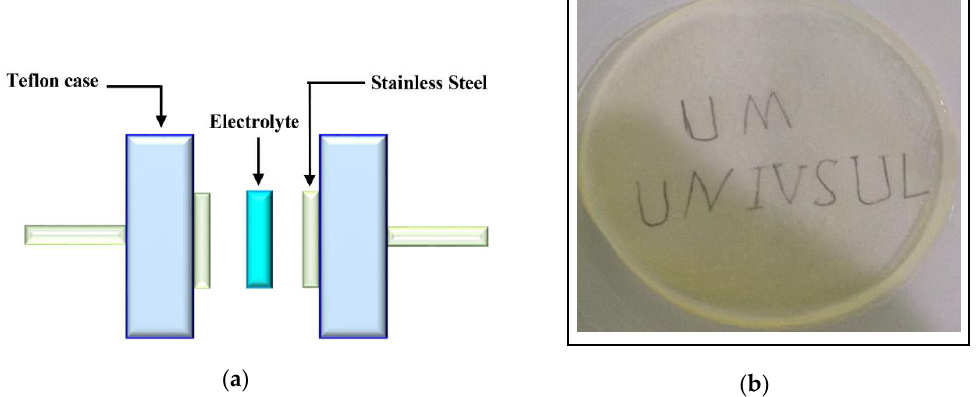
Figure 1. ( a ) Schematic diagram for impedance, TNM and LSV measurements. ( b ) Real image of a prepared SPE sample.